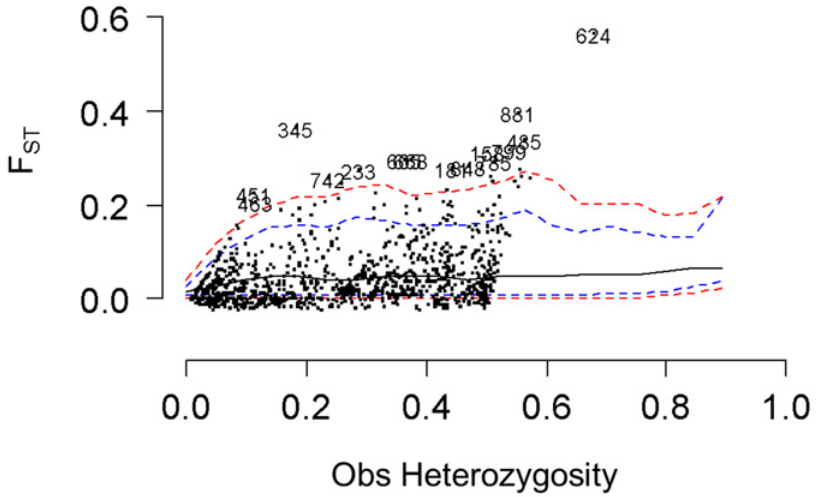
Fig 6. Results of the coalescent outlier search under the hierarchical island model. Blue dashed line: 95% neutral envelop; red dashed line: 99% neutral envelop. Only loci above the neutral envelop and retained after multiple corrections (FDR = 10%) are shown.